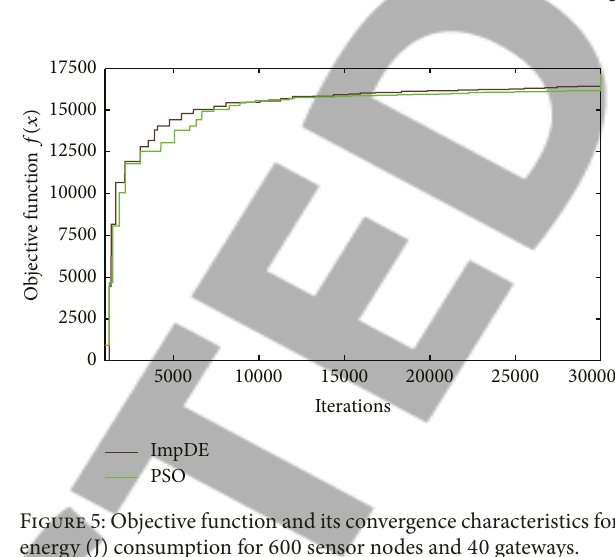
Figure 5: Objective function and its convergence characteristics for energy (J) consumption for 600 sensor nodes and 40 gateways.